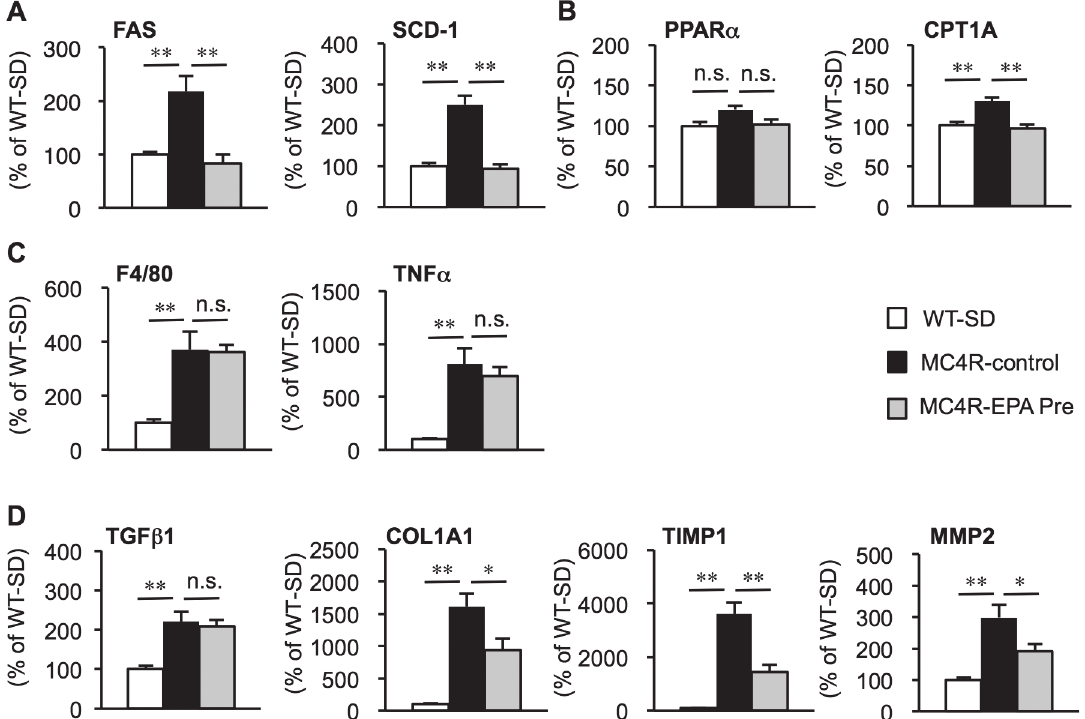
Fig 3. Effect of EPA on hepatic mRNA expression in MC4R-KO mice. Hepatic mRNA expression levels after 24 weeks of EPA treatment. mRNA expression of genes related to de novo lipogenesis (fatty acid synthase (FAS) and stearoyl-CoA desaturase (SCD-1)) (A), β -oxidation (peroxisome proliferators-activated receptor α PPAR α and carnitine palmitoyltransferase 1A (CTP-1A)) (B), inflammatory markers (F4/80 and tumor necrosis factor α (TNF α ) (C) and fibrogenic factors (transforming growth factor β 1 (TGF β 1), collagen α 1(I) (COL1A1), tissue inhibitor of metalloproteinase-1 (TIMP1) and matrix metalloproteinase-2 (MMP2)) (D). * P < 0.05; ** P < 0.01; n.s., not significant. WT-SD, n = 8; MC4R-control, n = 7; MC4R-EPA Pre, n = 10.